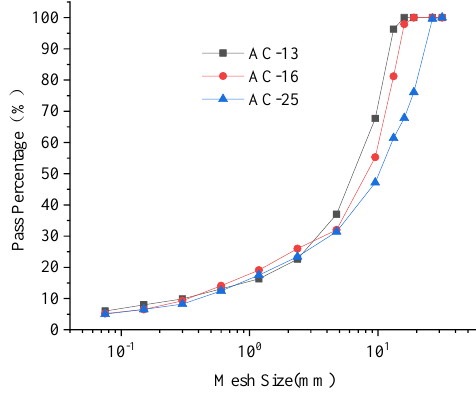
Figure 3. Grading curve of formed specimen.